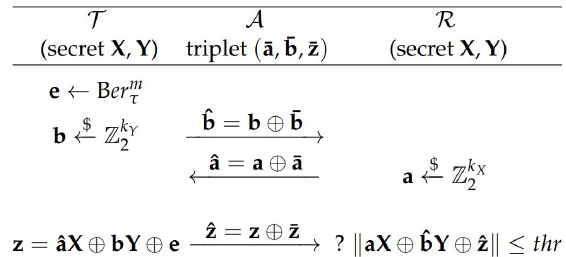
Figure 2. The OOV attack against Random-HB# and